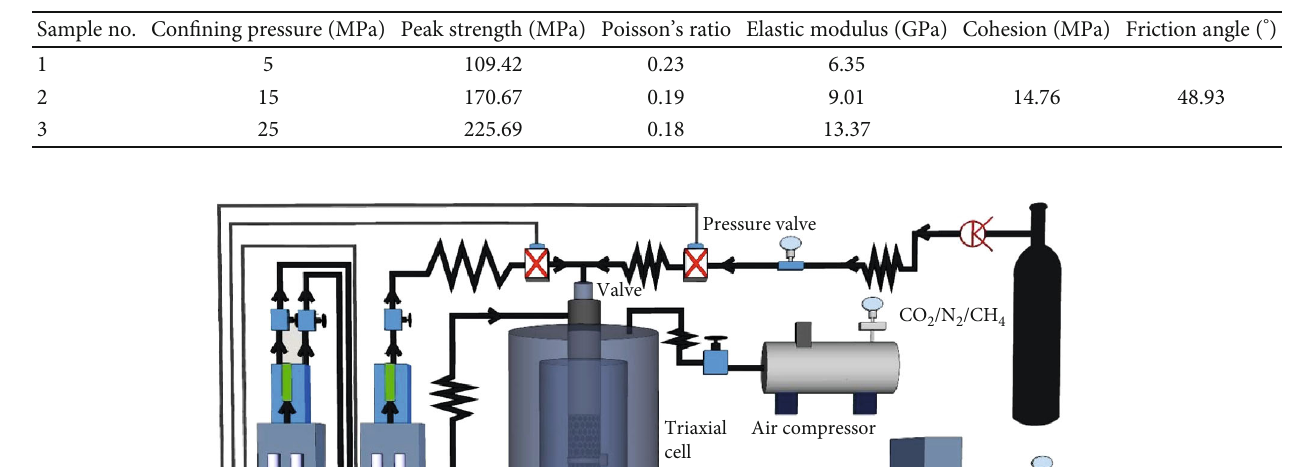
Figure 1: Fractured samples: (a) single-fracture; (b) double-fracture. Table 1: Mechanical property of the sandstone.